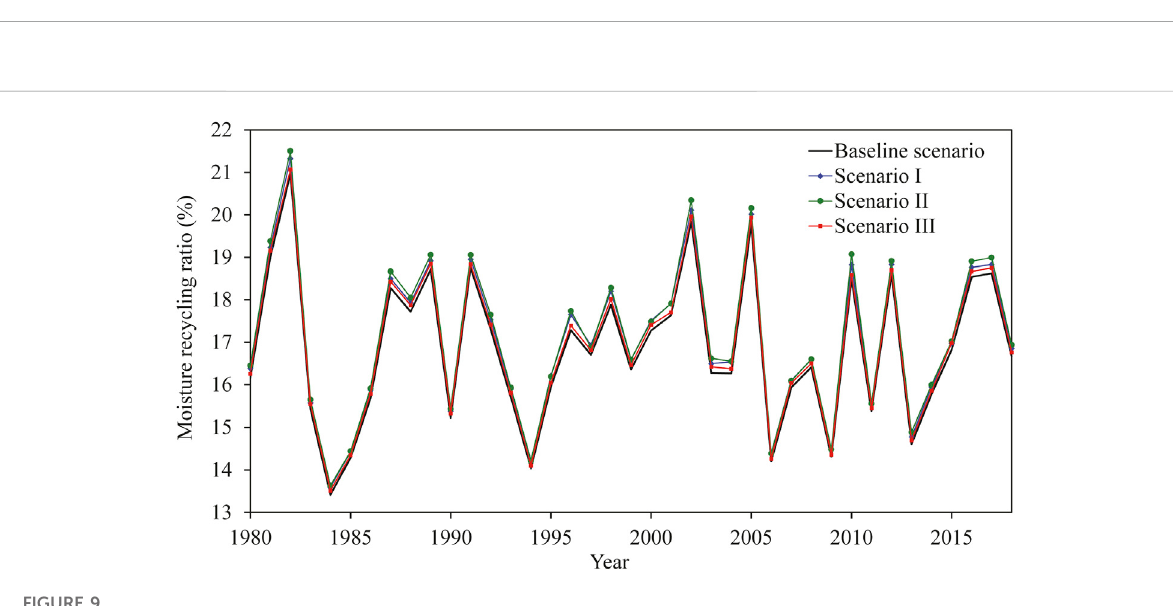
FIGURE 8 SpatialdistributionofreprecipitationintheTarimBasin of (A) thebaselinescenarioand (B) ScenarioIII, and (C) thedifference between Scenario III and the baseline scenario.